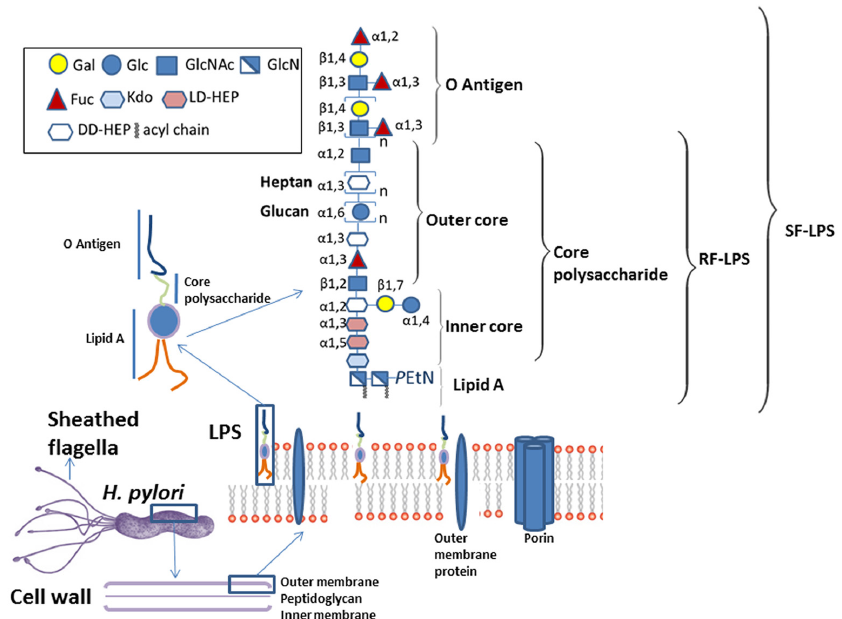
Figure 2. Components of the surface of H. pylori that have the potential to interact with host molecules include the flagella, outer membrane proteins and lipopolysaccharide (LPS). The location of H. pylori flagella, the structure of the Gram-negative bacterial cell wall together with the detailed composition of H. pylori LPS as described by Li et al [59] are shown.